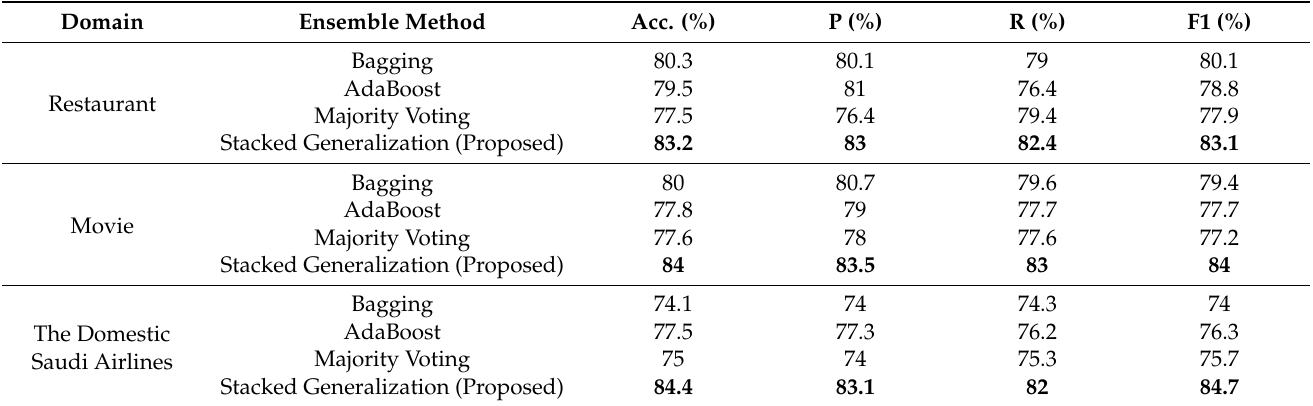
Table 7. Performance comparison of different ensemble methods with proposed method on restaurant